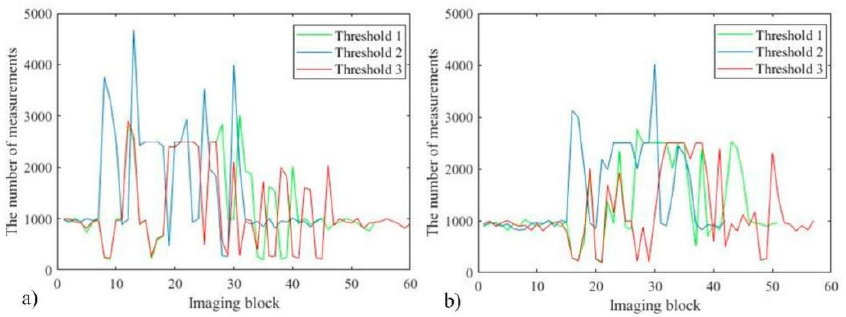
Figure 9. Comparison curve of the number of measurements.